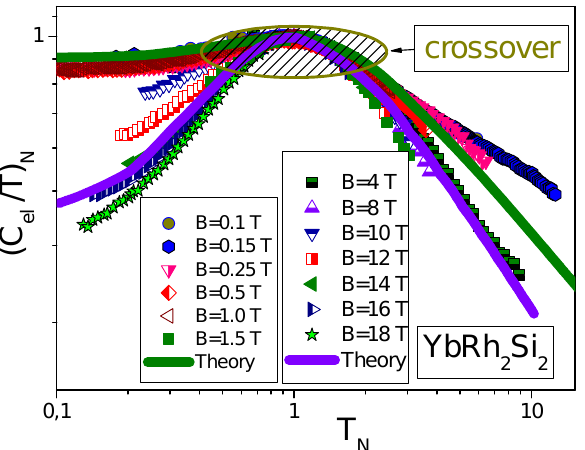
Figure 2. The normalized specific heat ( C el / T ) N = M ∗ of YbRh 2 Si 2 as a function of normalized N temperature T N under the application of magnetic field B shown in the left hand legend (low B ) and the right hand legend (high B ) The experimental data is extracted from the measurement of of FIG. 3: The normalized specific heat ( C el /T ) N = M ∗ N C / T measurements on the archetypical HF metal YbRh 2 Si 2 [52,53]. The low-field calculations of YbRh 2 Si 2 as a function of normalized temperature T N un- M ∗ are depicted by the solid green curve. The solid blue curve representing high-field calculations der the application of magnetic field B shown in the left hand N ( B 18) is performed for the fully polarized quasiparticle band [29]. Starting from relatively high legend (low B ) and the right hand legend (high B ) The exper- ∼ magnetic fields B 4 T, the specific heat demonstrates the same behavior as ( C mag / T ) = M ∗ of imental data is extracted from the measurement of C/T mea- N ≥ Lu 3 Cu 2 Sb 3 O 14 shown in Figure surements on the archetypical HF metal YbRh 2 Si 2 [53, 54]. The low-field calculations of M ∗ are depicted by the solid N green curve. The solid blue curve representing high-field cal- culations ( B 18) is performed for the fully polarized qua- ∼ siparticle band [29]. Starting from relatively high magnetic fields B 4 T, the specific heat demonstrates the same be- ≥ havior as ( C mag /T ) = M ∗ of Lu 3 Cu 2 Sb 3 O 14 shown in Fig. N 1.